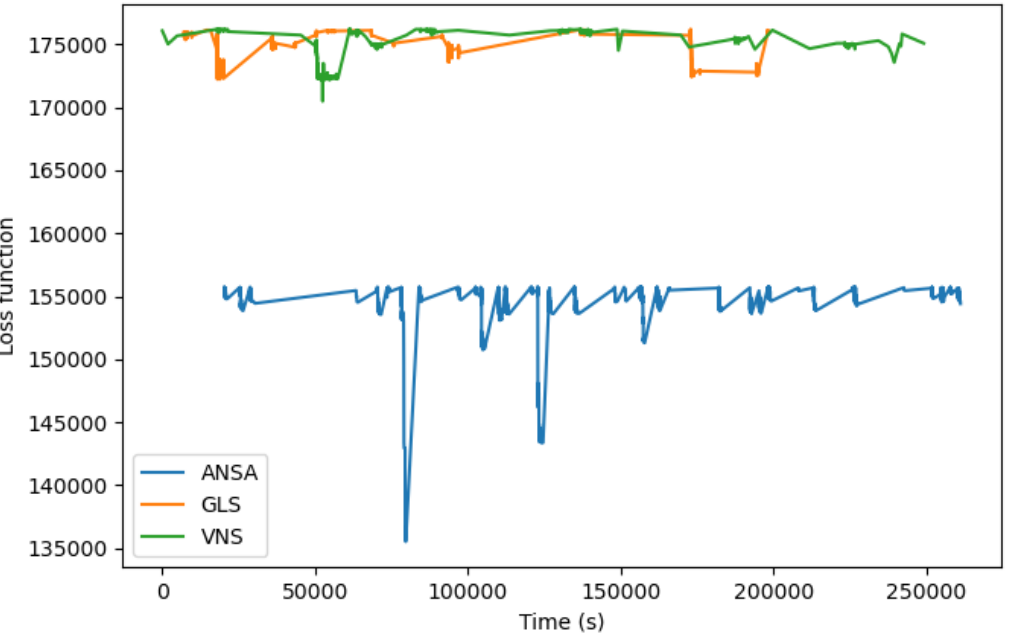
The value of the loss function for ten blocked links in the Zlín region over the course of computation. The graph shows how the values of the local minima emerged over